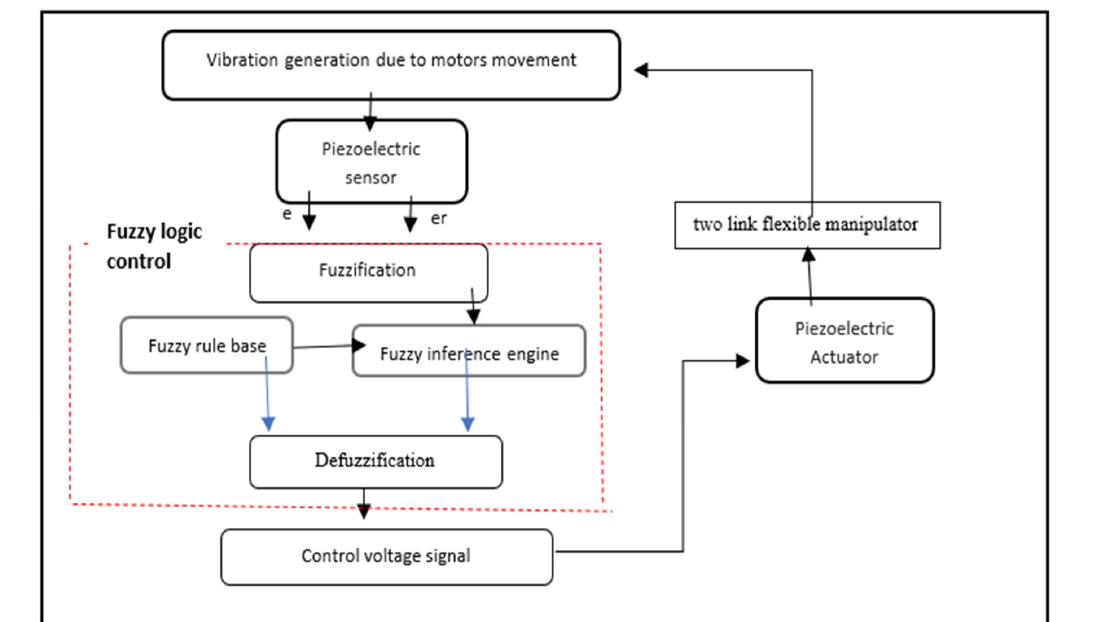
Fig. 2. Research method of the system comprises principle fuzzy controller.